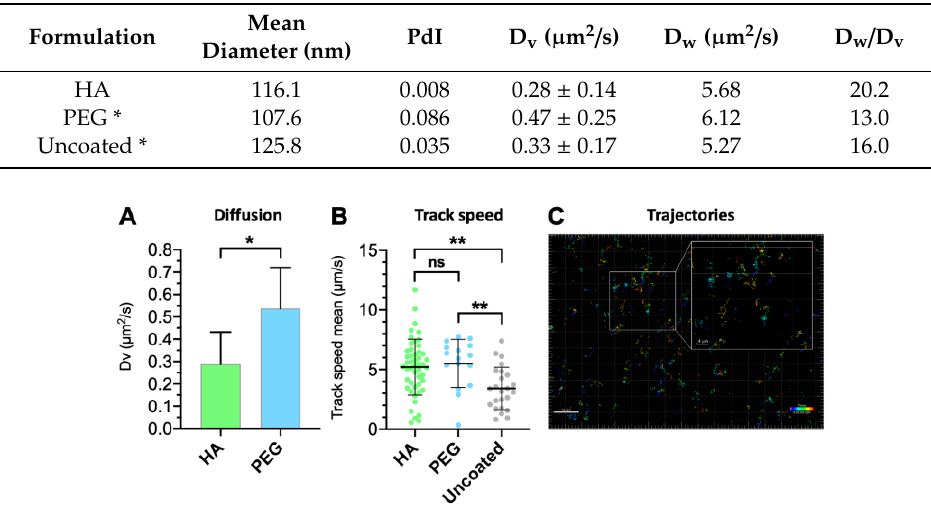
Table 2. Comparison of the vitreal di ff usion of HA-coated, PEG-coated, and uncoated liposome formulations. D v was obtained experimentally by single-particle tracking for 1 s, and the D w was calculated based on the Stoke–Einstein equation ( N = 3). * Data from Reference [29].